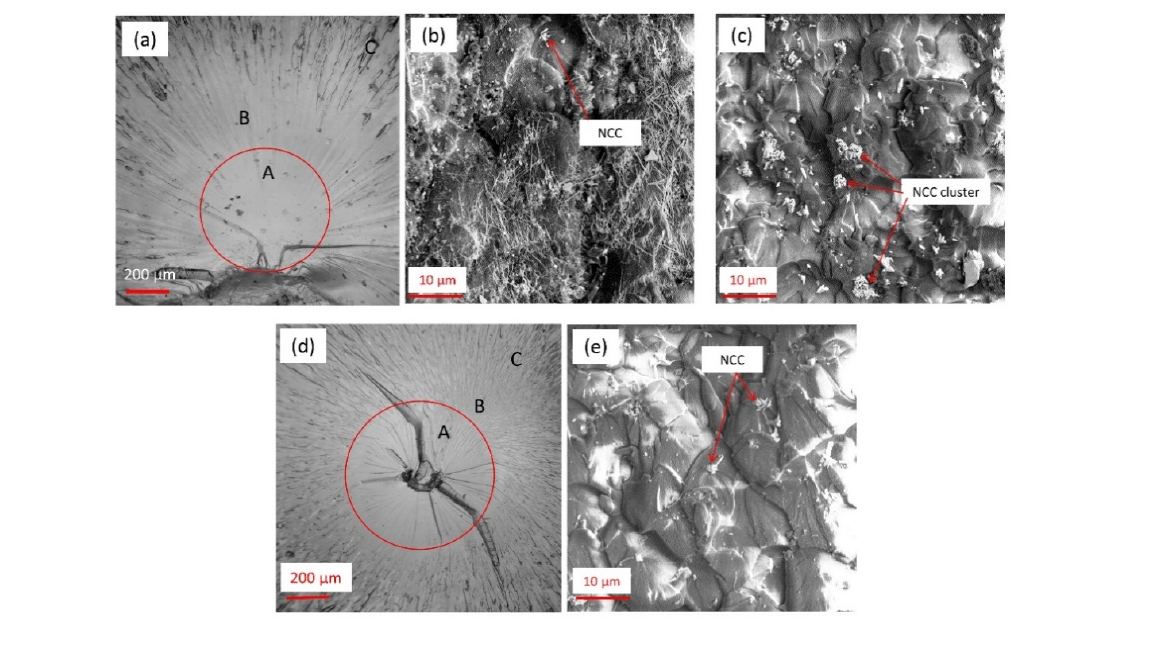
Fig. 4. The micrographs of the surfaces of broken tensile specimens (a) unaged neat UPR, (b) unaged 1 wt% NCC, (c) unaged 5 wt% NCC, (d) aged neat UPR, (e) aged 1 wt% NCC. Images (a) and (d) were taken using a light microscope, while images (b), (c) and (e) were taken using an electron